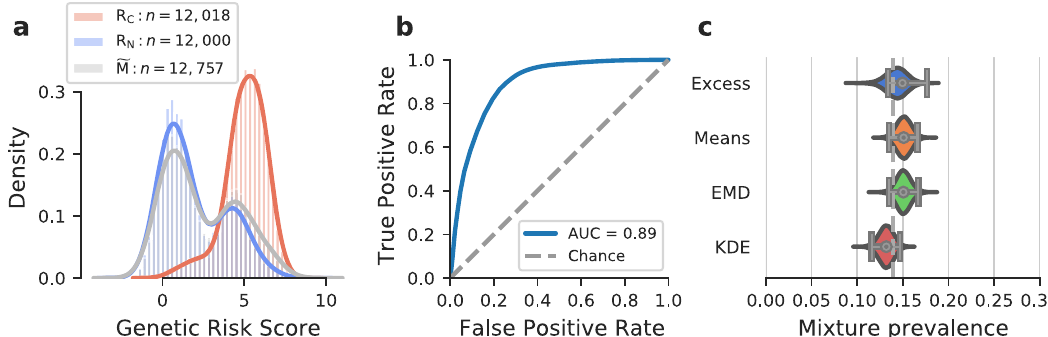
Fig. 5 Coeliac disease dataset worked example. A comparison of the four methods applied to a gluten-free cohort from the UK biobank (mixture population e M). a The reference and the mixture distributions (R C , shaded red, R N , shaded blue, e M shaded grey, respectively). b A receiver operating characteristic (ROC) curve for the two reference distributions (blue). c Estimated values of prevalence ^ p (grey bullseye) and 95% con fi dence intervals C (horizontal lines with vertical bars at the ends) are plotted on the right showing estimates of Excess = 15.0%, Means = 15.1%, EMD = 15.1%, KDE = 13.2%. The violin plots show the distribution of the 100,000 estimates of prevalence ( p 0 ) in the bootstrap cohorts. The proportion of participants adhering to a C gluten-free diet and reporting coeliac disease is shown as a dashed vertical line. Sample sizes: non-cases UK Biobank ( n ¼ 12 ; 000), cases coeliac